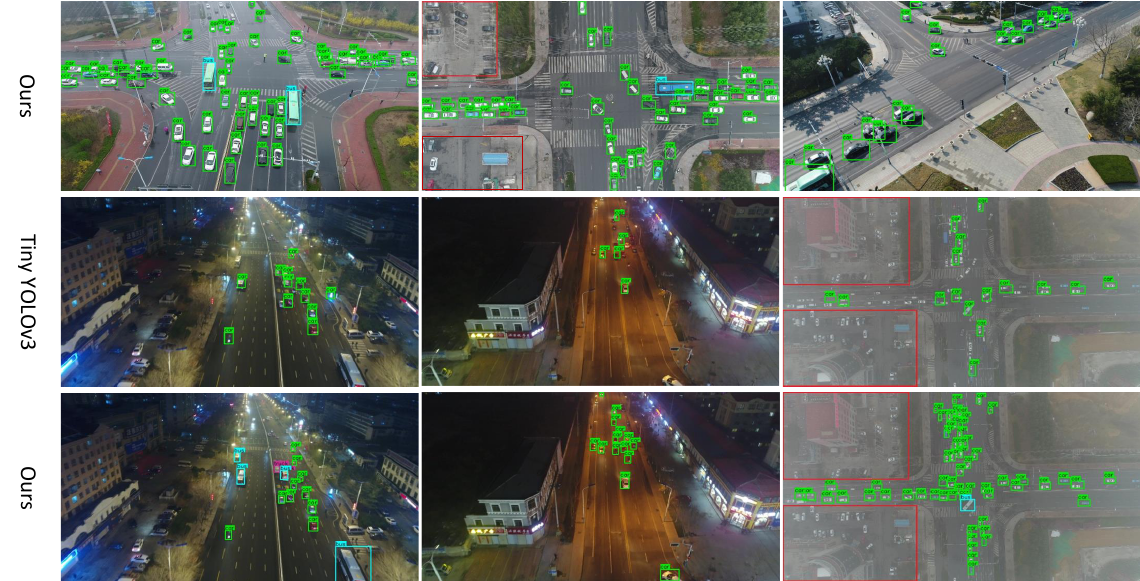
Figure 4. Some visualization results of our proposed method and Tiny YOLOv3. The first two lines of images are from the validation set of Visdrone-2018-VID; the last four lines of images are from the testing set of UAVDT-DET. In each comparative example, the top picture shows the results of our method, the bottom picture shows the results of Tiny YOLOv3. The areas inside the red rectangles have no annotations, so we did not detect these areas.